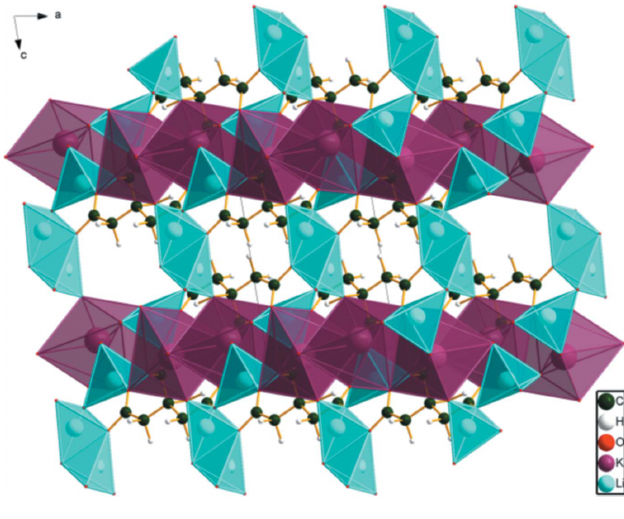
Figure 4 Crystal structure of Li 2 KC 6 H 5 O 7 , viewed down the b -axis